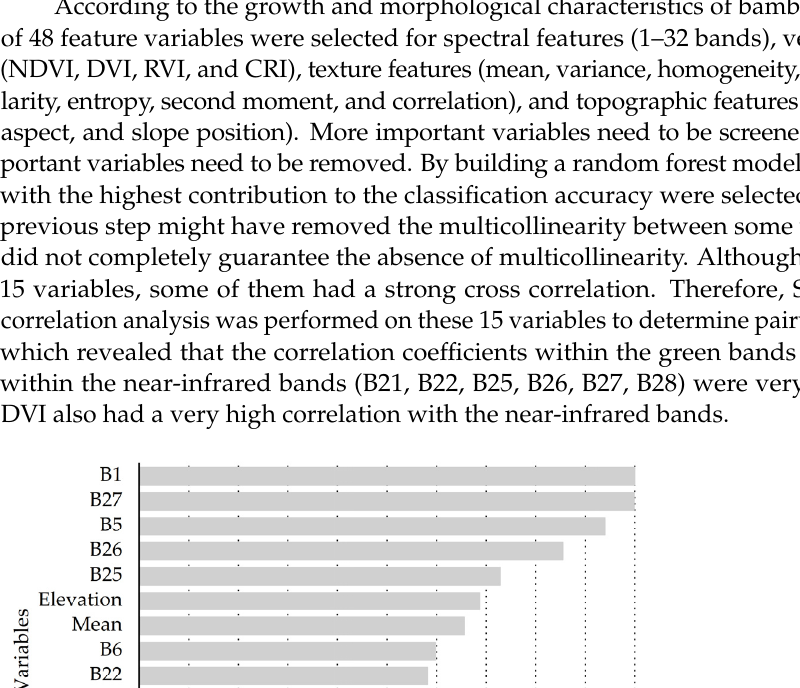
Figure 5. ( a ) Confusion matrix and evaluation indicators of SAM; ( b ) classification map of SAM.